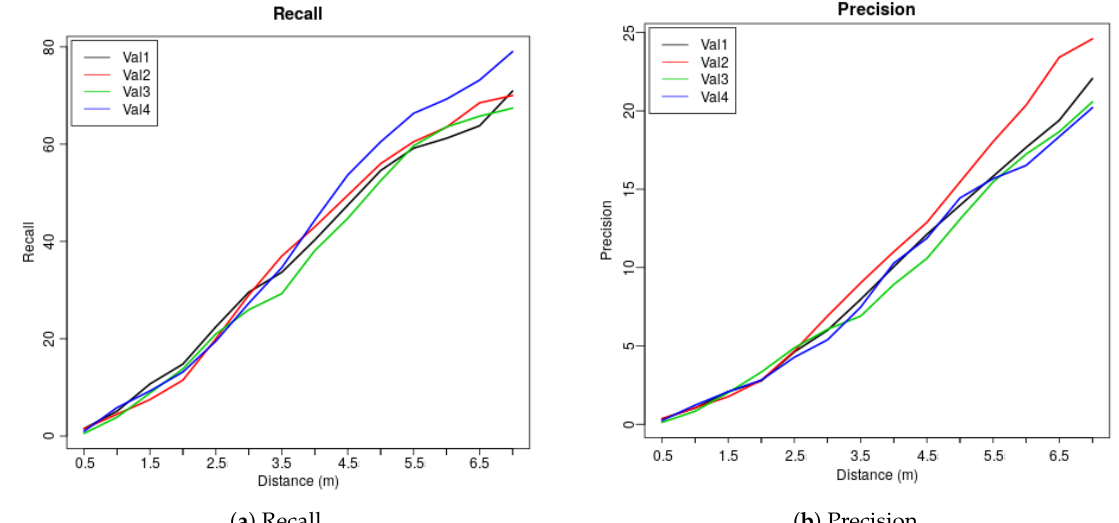
Figure 12. Results of the algorithm using three windows with different sizes: ( a ) Recall, ( b ) Precision.